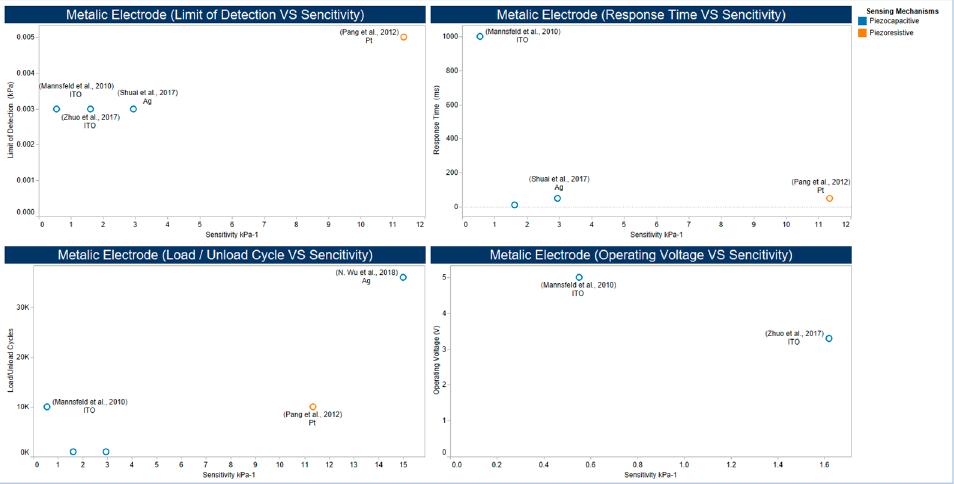
Figure 19. Performance of some sensors based on metallic electrodes.